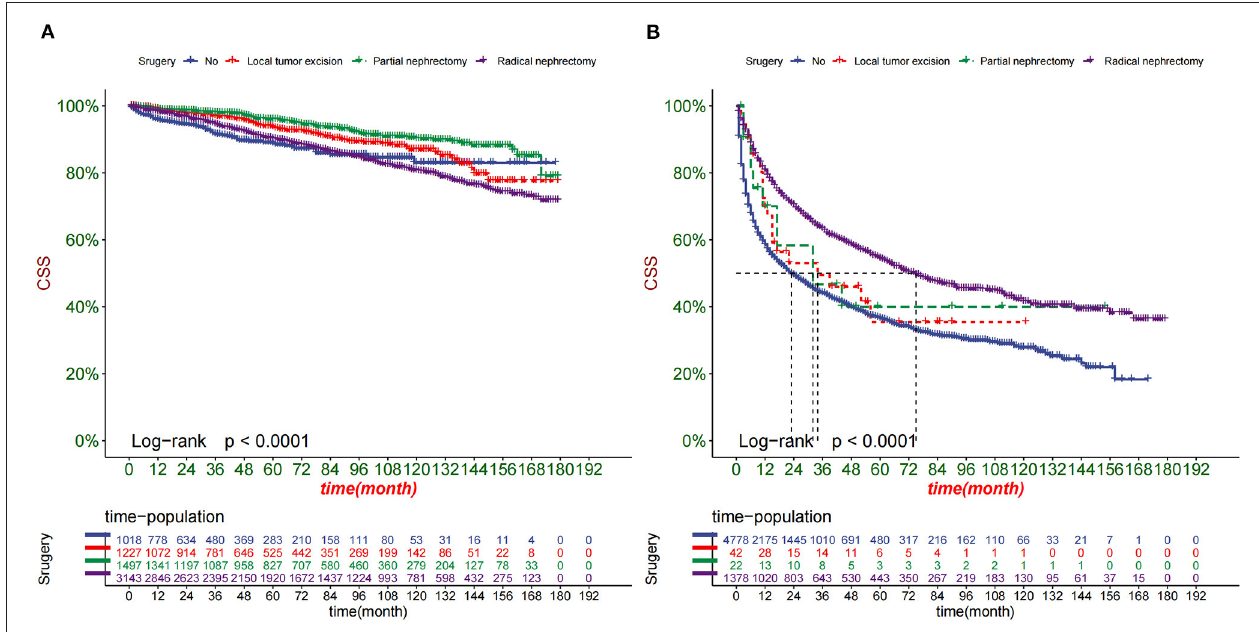
FIGURE 7 | Kaplan-Meier curves of patients with different surgery in the low-risk group (A) and high-risk group (B)